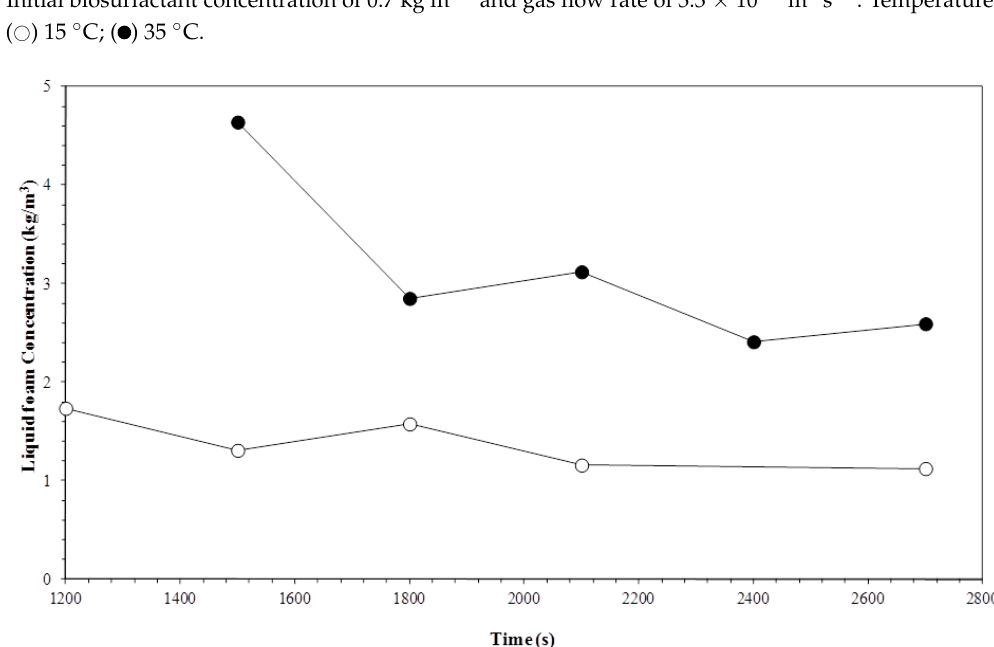
Figure 7. Variation in the liquid foam concentration with time and temperature. Experiment conditions: Initial biosurfactant concentration of 0.7 kg m − 3 and gas flow rate of 1 × 10 − 6 m 3 s − 1 . Temperatures: ( ○ ) 15 °C; ( ● ) 35 °C.